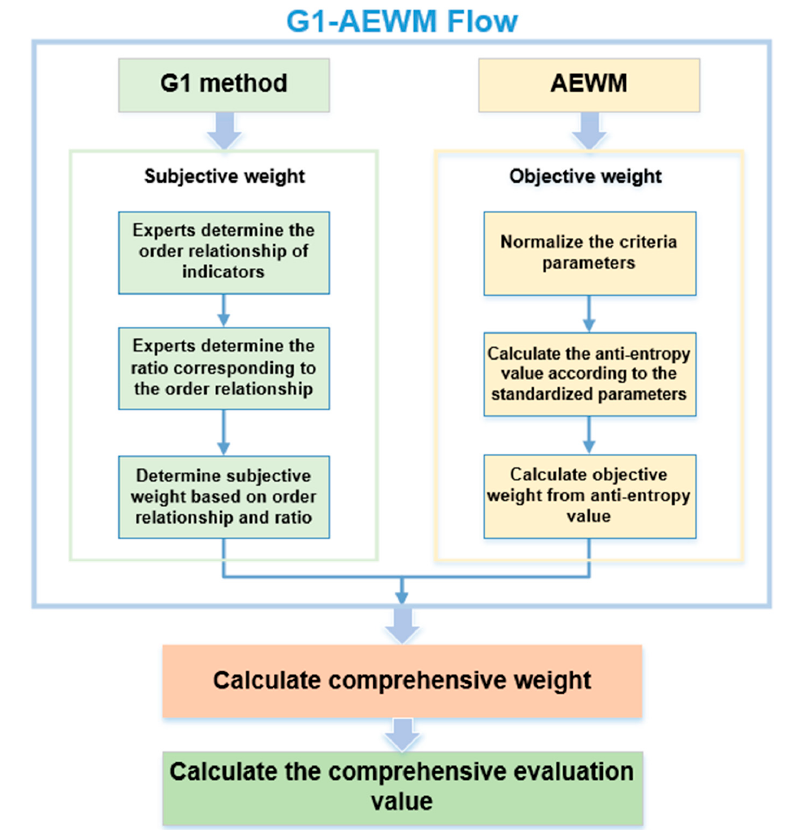
Figure 2. G1-AEWM Flow.